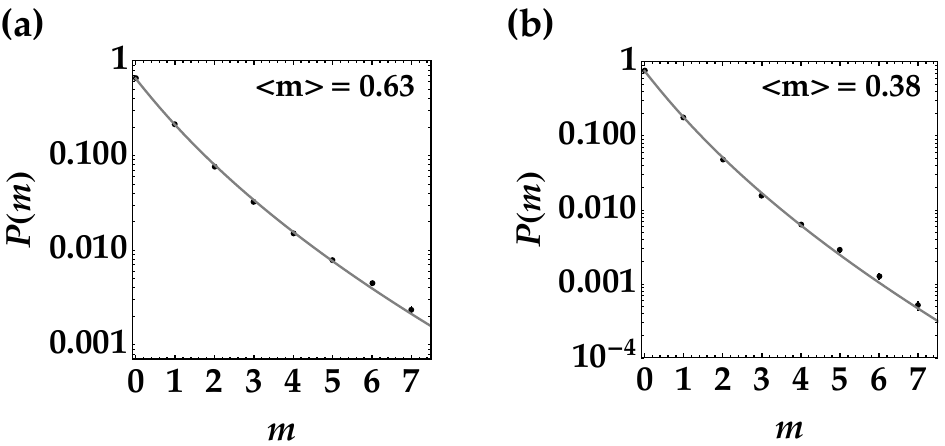
Figure 4. Detected-photon number distributions reconstructed at one BS output for two mean values of the speckled-speckle field. Black dots and error bars: experimental data; gray curves: theoretical fitting functions according to Equation (4), in which µ f = 1.22, while µ s is the only fitting parameter. The obtained values are: µ s = 1.74 ± 0.02 in panel ( a ) and µ s = 1.76 ± 0.02 in panel ( b ). The corresponding values of fidelity are: f = 0.9999 and f = 0.9999,